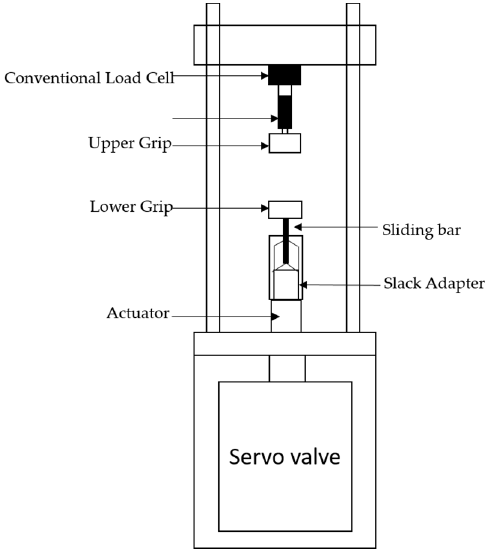
Figure 1. Schematic diagram of the high-speed testing machine.